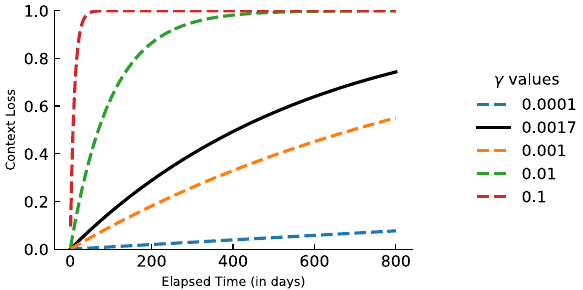
Fig. 4 Loss of context L as a function of time delay t j . Loss of context as a function of the time delay ( t j ) between game session j and j − 1 for different parameter settings of γ . Colours represent different values of γ . The black curve shows the estimated context loss function for the Lumosity